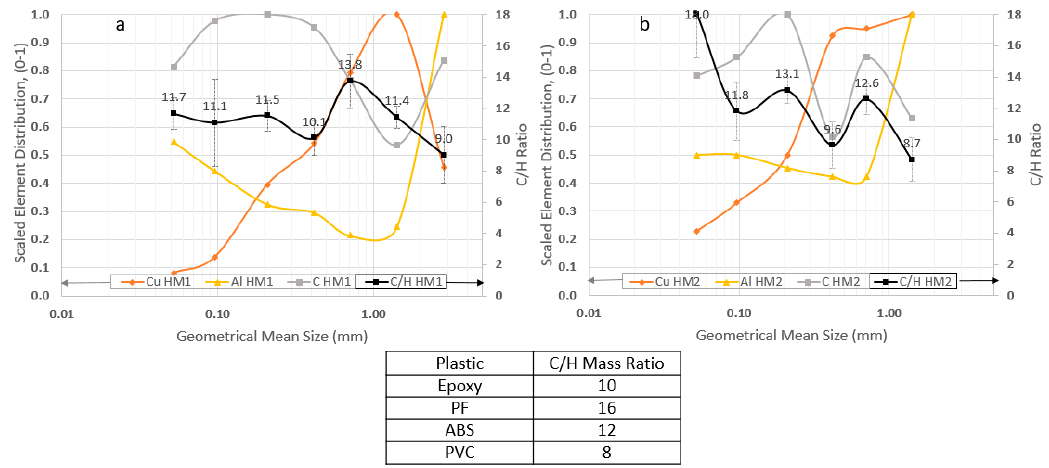
Figure 4. Scaled distribution of Cu and Al in comparison with the C / H mass ratio as a function of the geometric mean size for the products of ( a ) Hammer Mill 1 and ( b ) Hammer Mill 2. The absolute uncertainty for the C / H ratio is given as an error bar. Experimental data points are connected with lines for the purpose of visual aid only.